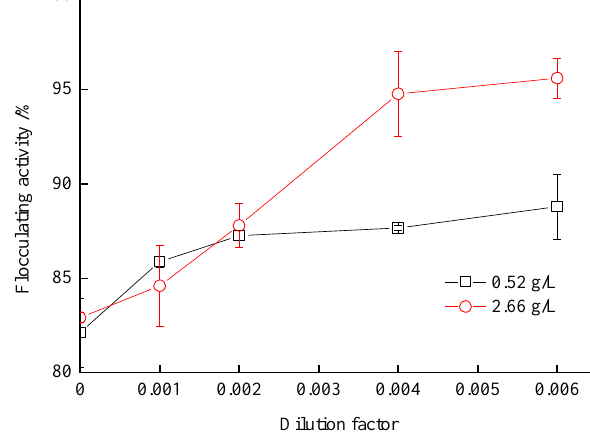
Figure 4. Improvement of flocculating activity of Scenedesmus quadricauda #507 by synthetic ocean water added (pH 11.5, 10 min stand of the concentration 0.52